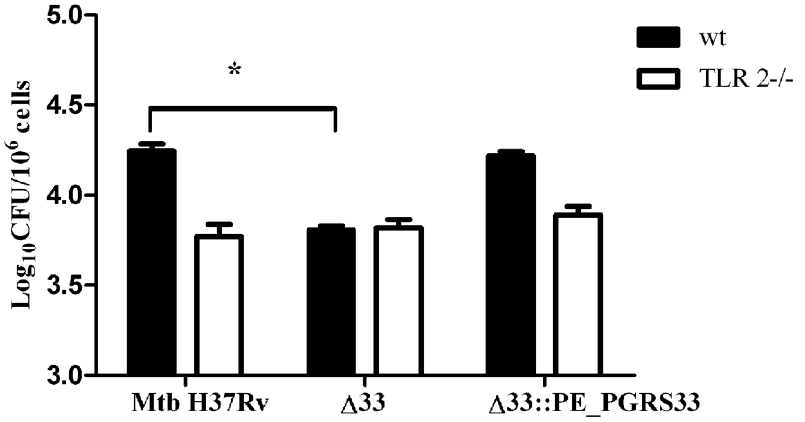
Fig 3. PE_PGRS33-mediated Mtb cell entry in macrophages occurs through interaction with TLR2. pMM0 isolated from C57Bl/6 and syngeneic TLR2 -/- mice were infected with Mtb H37Rv, Mtb Δ 33